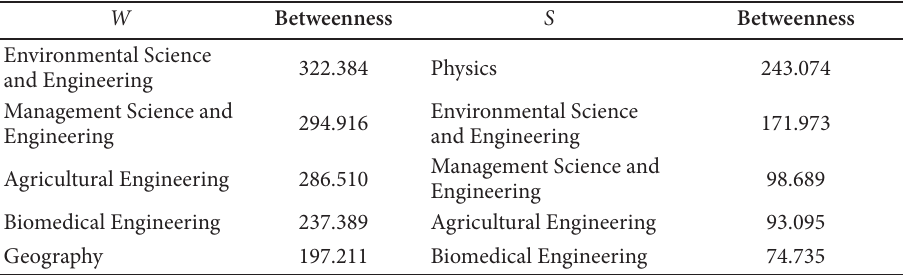
Table 3. Nodes with the largest betweenness in discipline knowledge network W Betweenness S Betweenness Environmental Science 322.384 Physics and Engineering